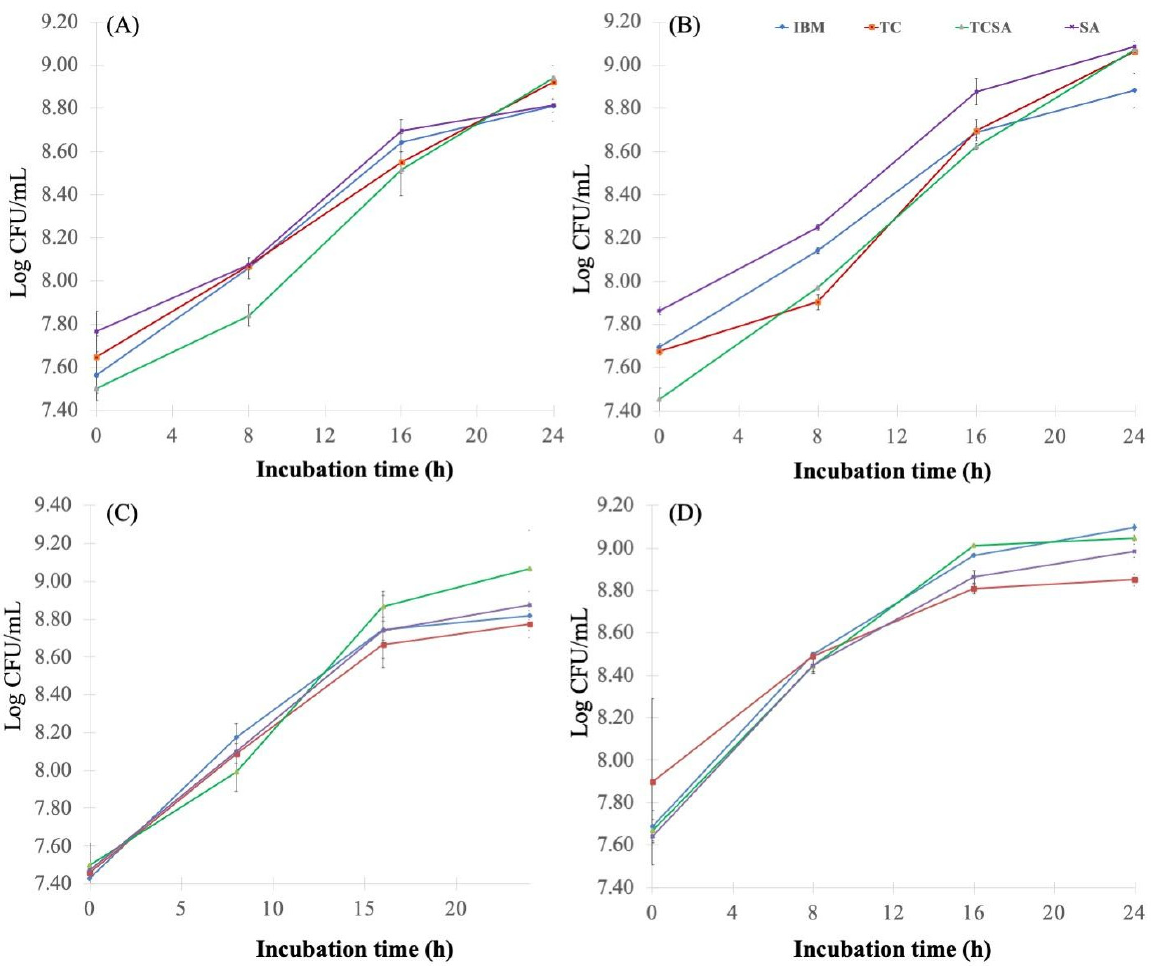
Figure 3. The viable cell count of EHA105-pEAQ cultivated in molasses-based media with antibiotic ( A ) and without antibiotic ( B ) supplementation and the colony-forming units of GV3101-pEAQ cultivated in molasses basal media with antibiotic ( C ) and without antibiotic ( D ) supplementation. SA: sulfuric acid pretreatment; TC: tricalcium phosphate pretreatment; TCSA: tricalcium phosphate and sulfuric acid pretreatment; IBM: initial basal medium. Error bars represent one standard deviation of six replicates.